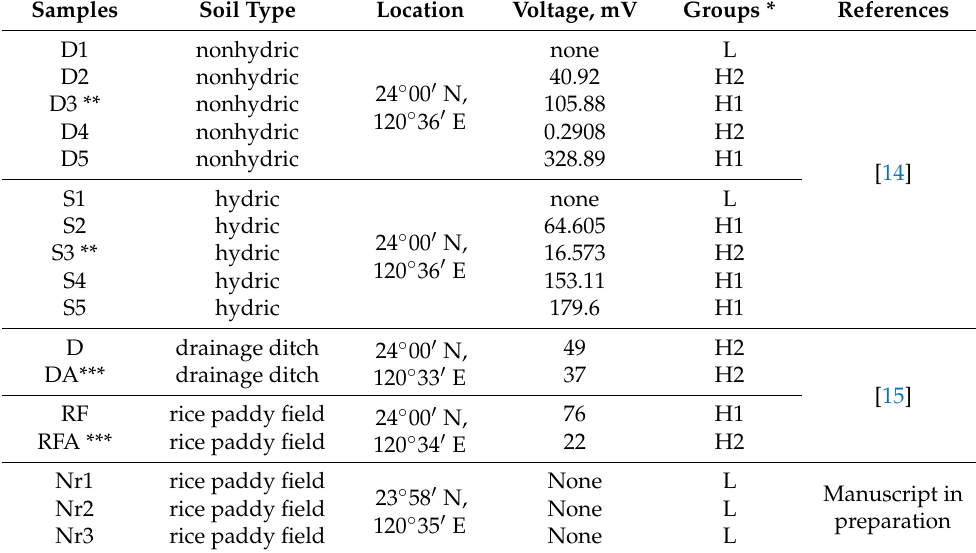
Table 1. Metadata. Study information includes sample numbers, soil types, voltage outputs, and groups for program